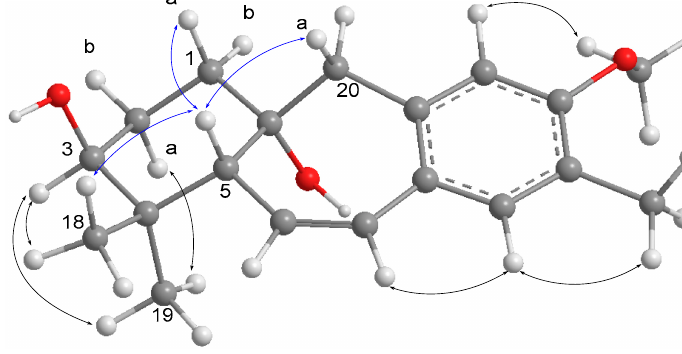
Figure 2 . Selected NOE correlations of 1 . Figure 2. Selected NOE correlations of 1